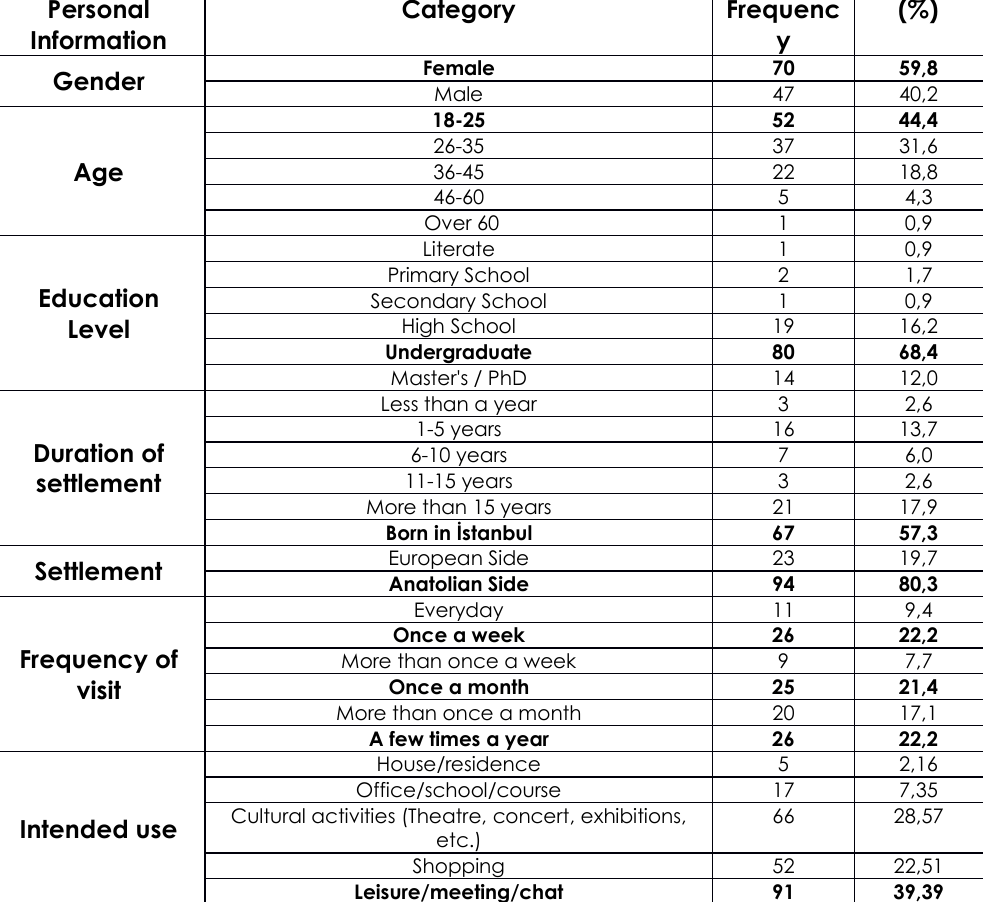
Table 1. Personal Information of the